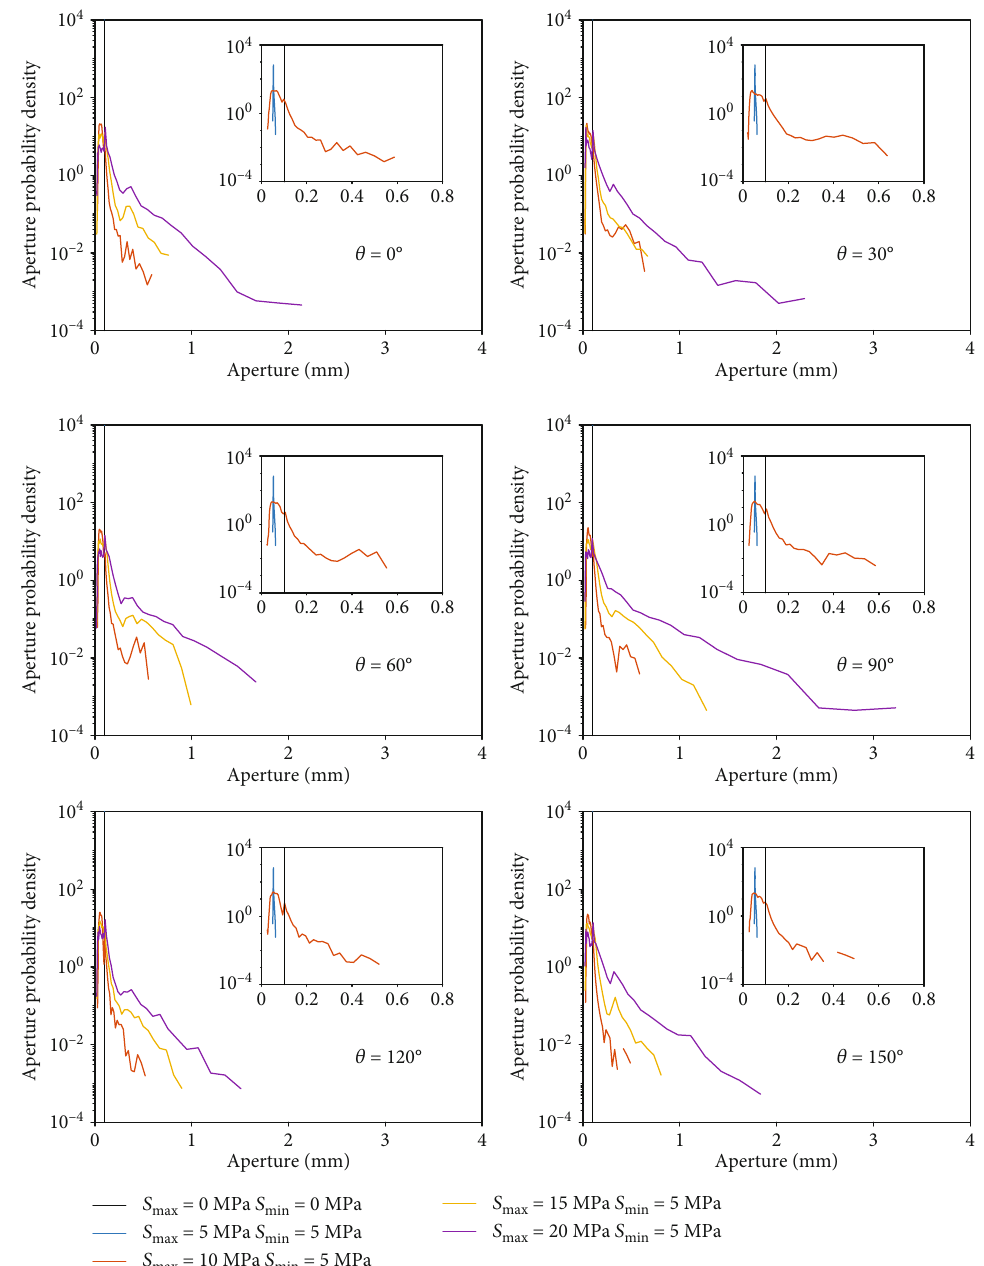
Figure 4: Probability density function of fracture apertures in the fracture network under various stress